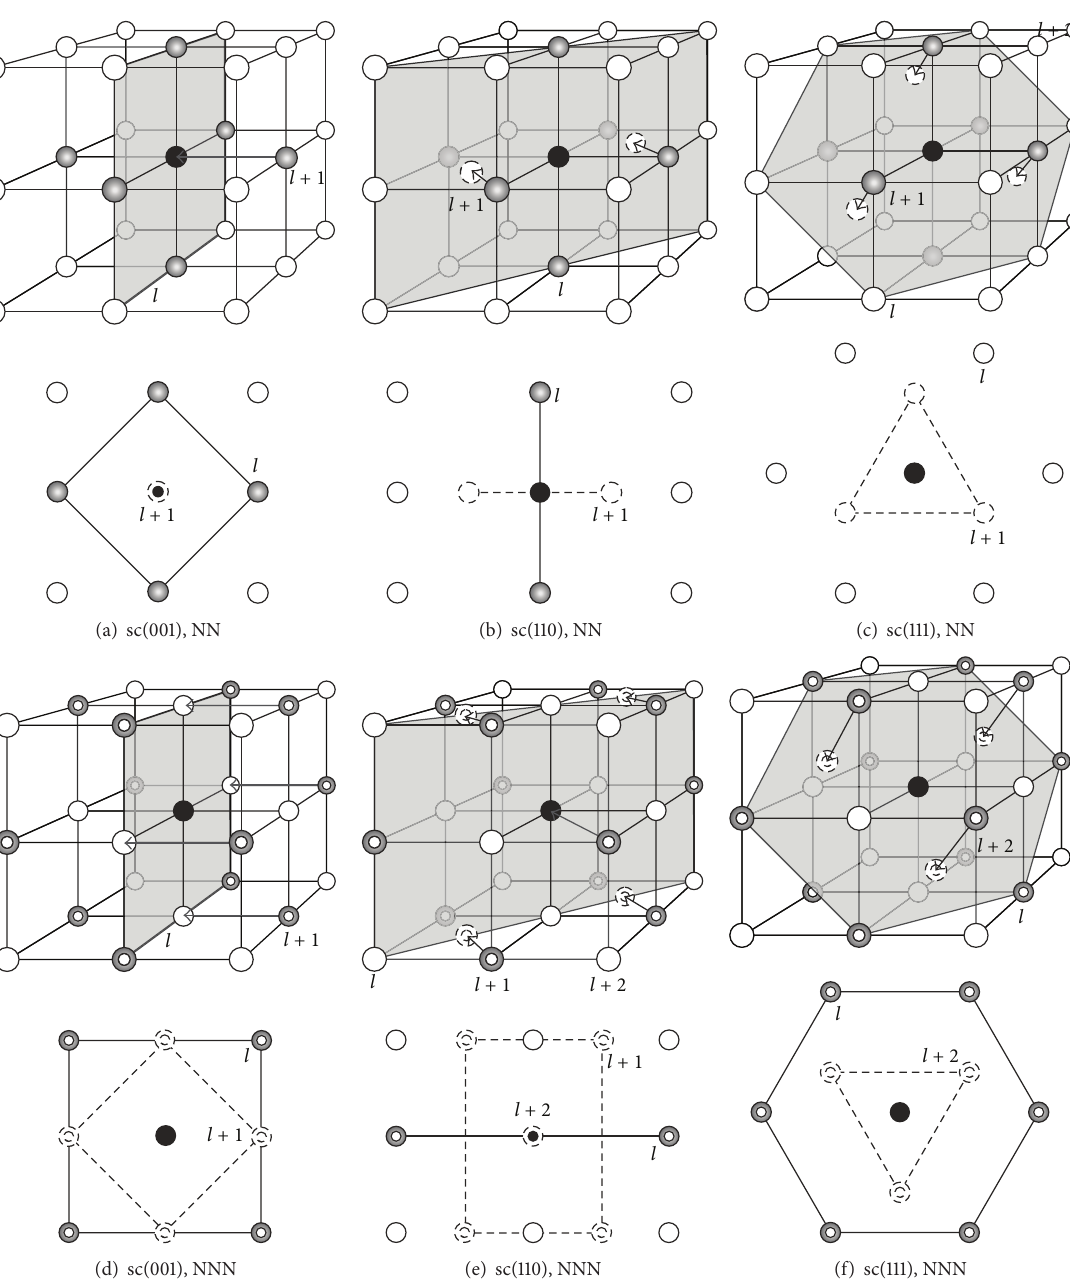
Figure 10: The distribution of ((a)–(c)) nearest, shaded circles, and ((d)–(f)) next nearest, shaded rings, neighbors of an arbitrary chosen spin (the central black circle) in sc thin films for three surface cuts: ((a), (d)) (001), ((b), (e)) (110), and ((c), (f)) (111). (See the text for explanation.) system is separated into two subsystems consisting of the layers with odd and even numbers,